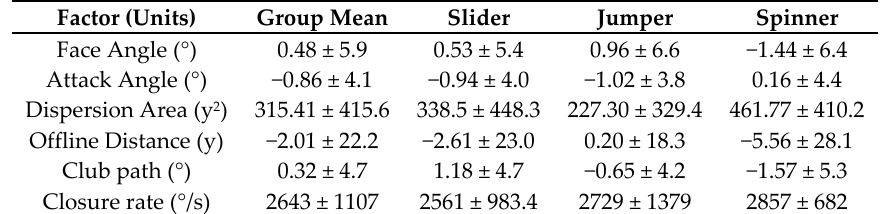
Table 5. Key impact factors measured through the launch monitored were paired with the power production